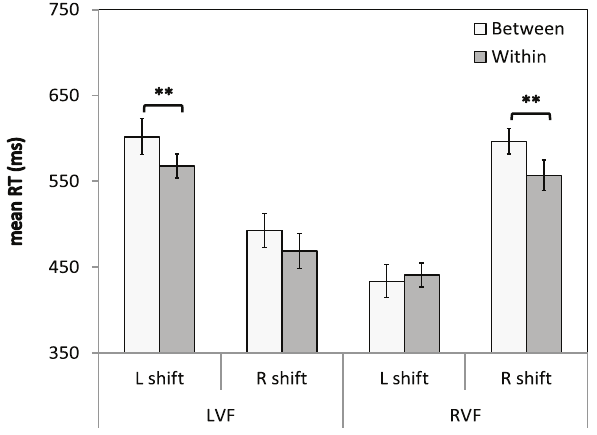
Figure 7. Visual field × Shift Type × Horizontal Shift Direction interaction. Mean RTs (ms) are shown for invalidly-cued trials that involved a horizontal shift in attention. LVF = left visual field; RVF = right visual field; L shift = left shift; R shift = right shift. Error bars indicate ±1SEM; ** indicates p <0.005 for each t-test comparison of between- and within-object For between-object shifts, mean RTs for shifting rightward in the LVF were 109 ms faster than mean RTs for shifting leftward in the LVF [leftward: M =602, SEM =21.4; rightward: M =493, SEM =20; t (56)=8.6, p <0.001]. Similarly, for between-object shifts, mean RTs for shifting leftward in the RVF were 143 ms faster than mean RTs for shifting rightward in the RVF [leftward: M =454, SEM =14.0; rightward: M =597, SEM =19.8; t (56)=10.9, p <0.001]. For within- object shifts, mean RTs for shifting rightward in the LVF were 99 ms faster than mean RTs for shifting leftward in the LVF [leftward: M =568, SEM =18.5; rightward: M =469, SEM =14.7; t (56)=9.2, ing leftward in the RVF were 116 ms faster than mean RTs for shifting rightward in the RVF [leftward: M =440, SEM =14.0; right- ward: M =556, SEM =18.8; t (56)=9.7, p <0.001]. Furthermore, t-tests